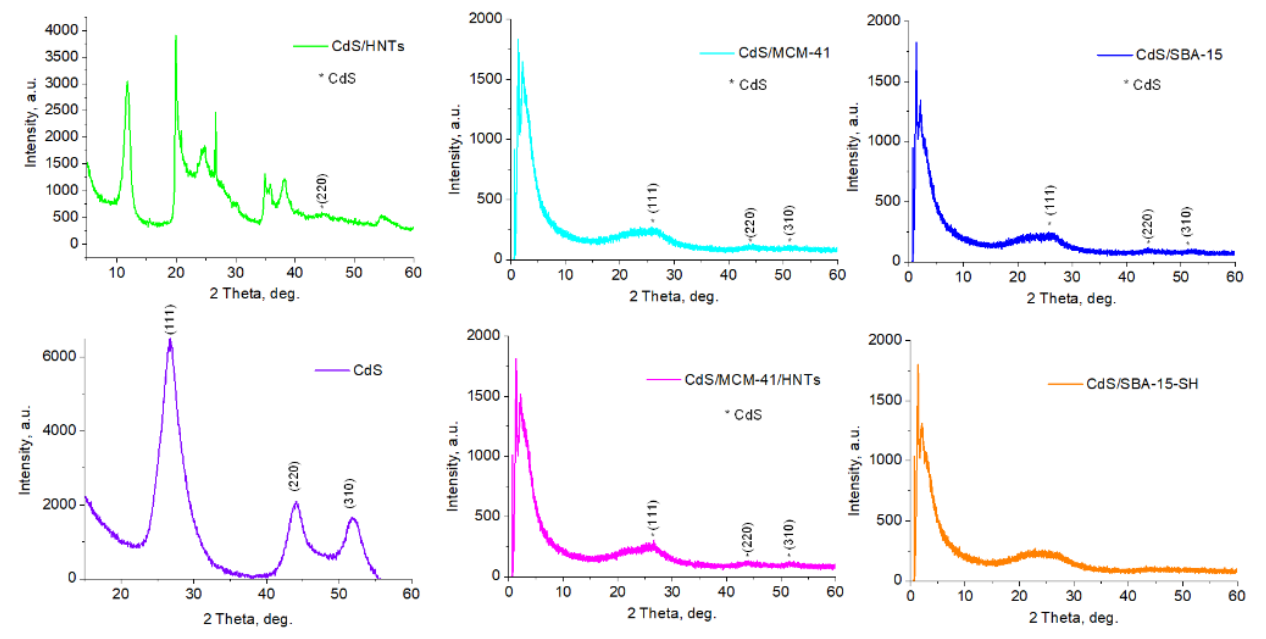
Figure 1. XRD of CdS, CdS/HNTs, CdS/MCM-41, CdS/MCM-41-HNTs, CdS/SBA-15 and CdS/SBA-15-SH.